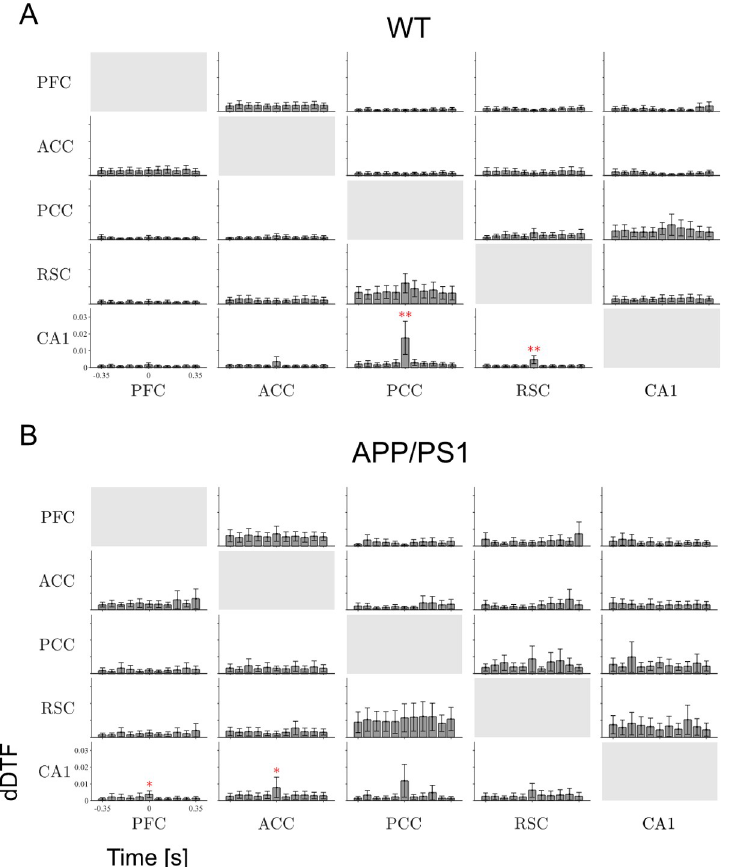
Fig 4. Effective coupling in the SWRs band. Time course of dDTF in SWRs (130–180 Hz) band, averaged over WT (A) and APP/PS1 (B) mice. Other abbreviations as in Figs 2 and 3. � p < 0.05, �� p < 0.01, ��� p < 0.001. Time bin size is 70